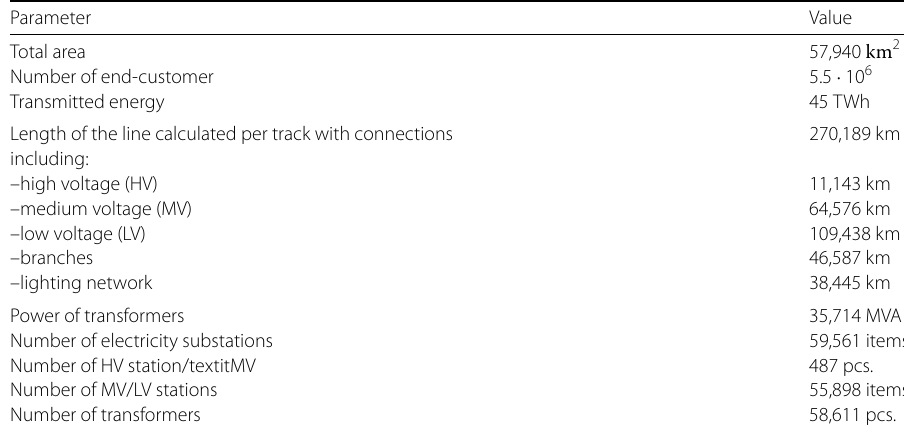
Table 1 DSO’s energy infrastructure parameters (state on December 31,